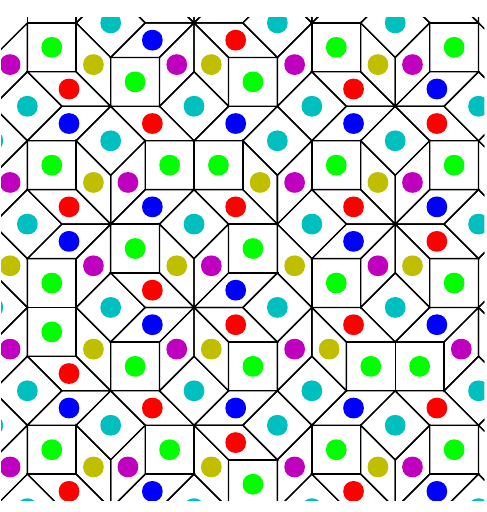
FIG. 1. A construction of the k ¼ 2 quasicrystalline topological phases for a d ¼ 2 , D ¼ 4 quasicrystal. Each color (of which there are six) is assigned a topological invariant that can be chosen independently (if no rotational symmetry is imposed) and represents the charge bound to the corresponding tile. If eightfold rotational symmetry is imposed, then there are two independent invariants, corresponding to the square and rhombus